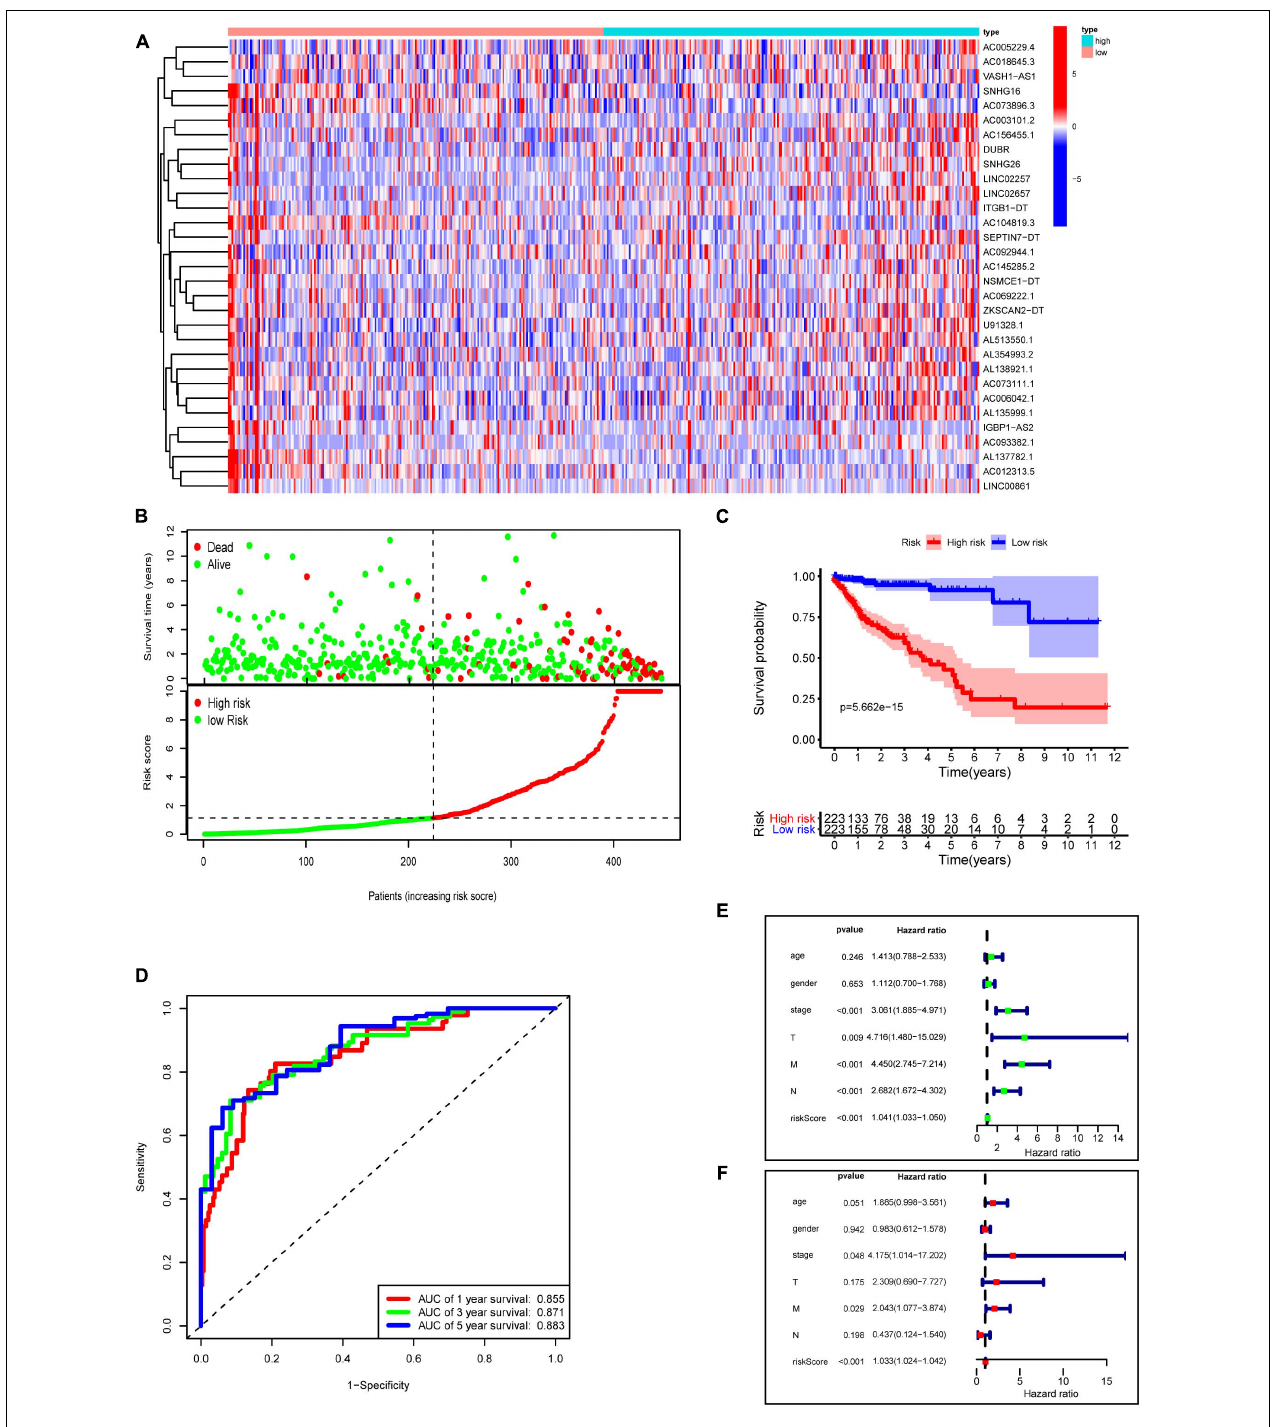
FIGURE 7 | Construction of a novel prognostic risk signature for COAD. (A) Heat map of the associations between the expression levels of the 31 m6A-related lncRNAs and risk scores in the TCGA data set. (B) Risk plots showing the distribution of risk scores and life/death status. (C) Kaplan–Meier curves showing that the low-risk subgroup had better OS than the high-risk subgroup in the TCGA-COAD cohort. (D) ROC curves of risk scores for predicting the 1/3/5-year survival in the TCGA data set. (E) The association between clinicopathological factors (including the risk score) and overall survival by univariate Cox regression analysis. (F) The association between clinicopathological factors (including the risk score) and overall survival by multivariate Cox regression analysis.